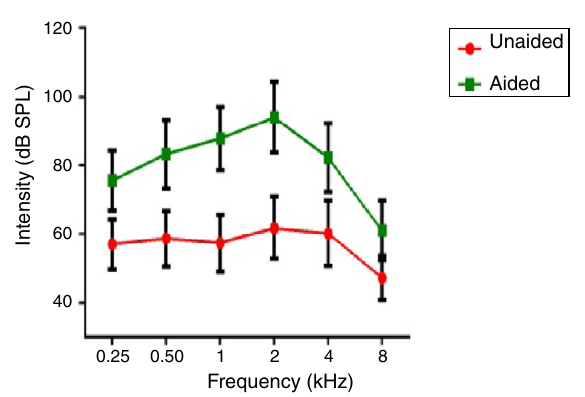
Mean and standard deviation of intensity of / (cid:2) a/ stimulus as a function of frequency in unaided and aided condi-